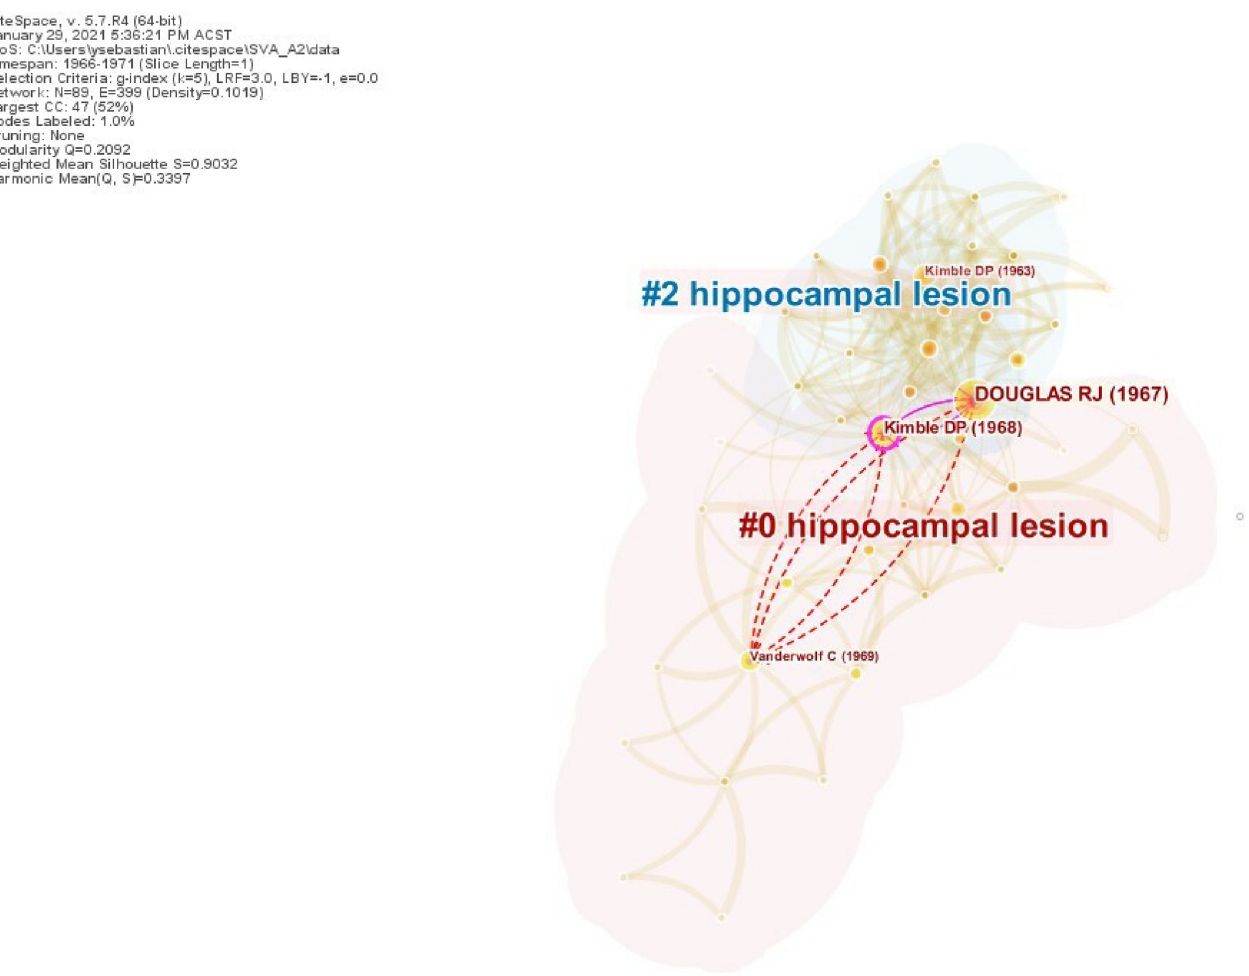
Fig 4. Case 2, Seed 1 ( S 2,1 ). The boundary-spanning mechanism exhibited by O’Keefe’s landmark publication in 1971.